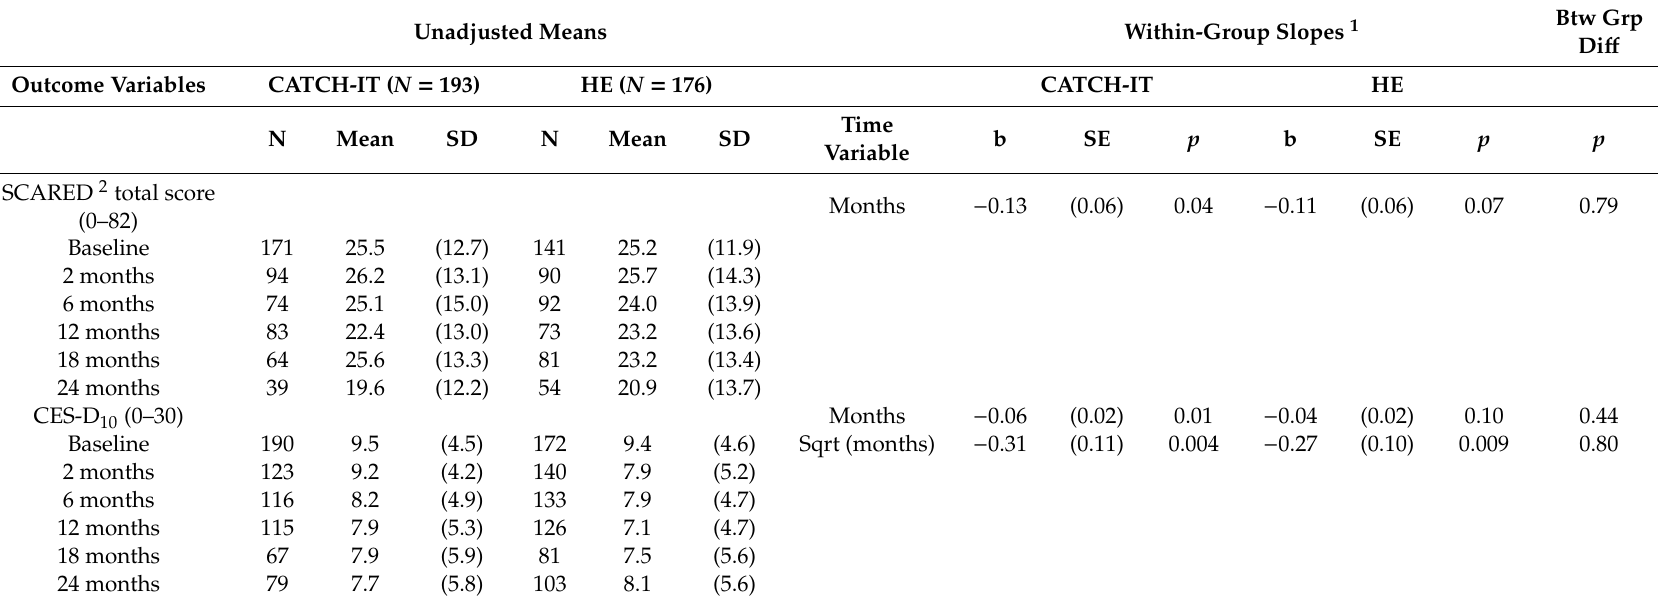
Table 1. Internalizing symptoms, baseline to 24